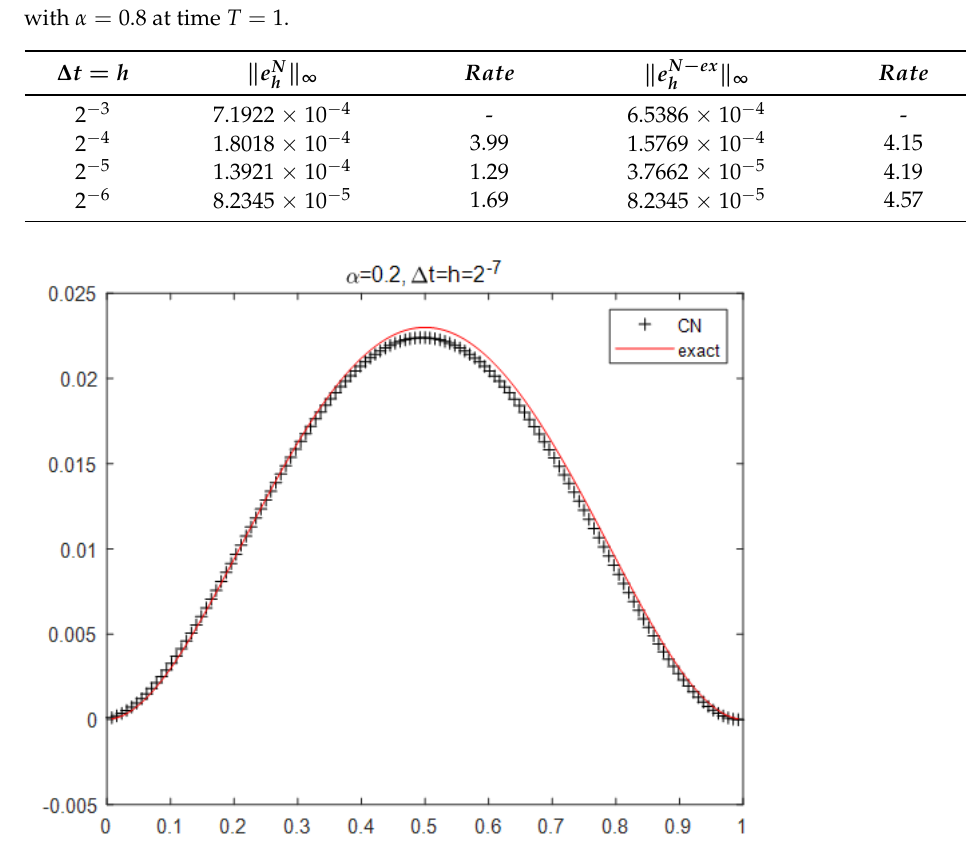
Figure 5. The numerical solution for the Crank-Nicolson scheme and exact solution for Example 2 with α = 0.2, ∆ t = h = 2 − 7 at time T =